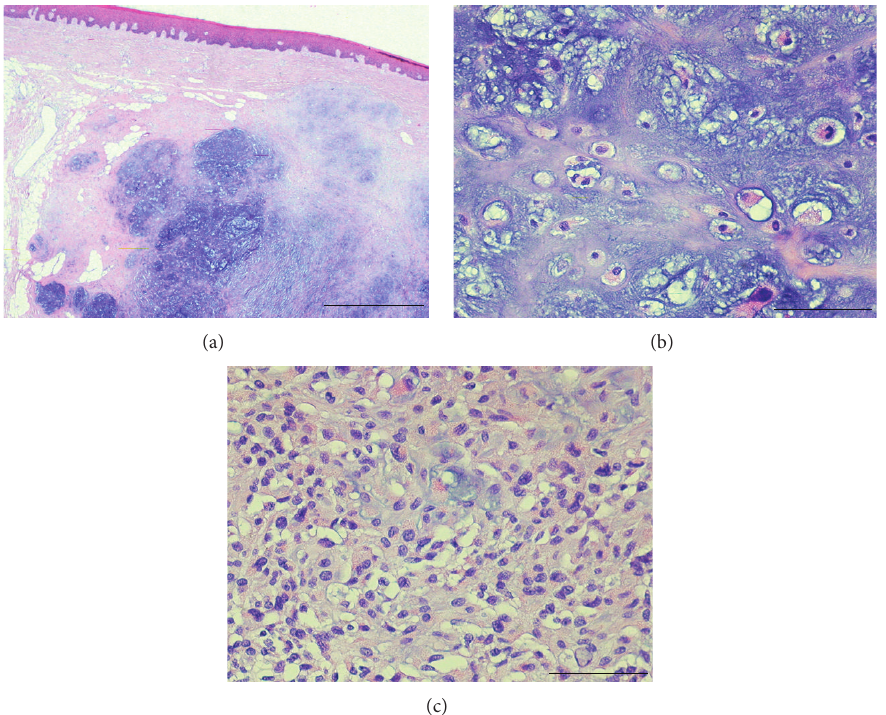
Figure 4: (a) Low-magnification view of the soft tissue chondroma located in the subepitelial hard palate. It shows a multilobular pattern with large blue areas, constituted of cartilaginous tissue, surrounded by a densely sclerotic fibrous tissue. No signs of ulceration are present. Haematoxilin-eosin, original magnification × 2, bar is 1mm. (b) The cartilaginous cells are immersed in an extremely abundant matrix and sometimes are binucleated (arrow). Haematoxilin-eosin, original magnification × 20, bar is 100 𝜇 m. (c) Focally, this lesion is constituted of smaller elements characterised by either oval or reniform nucleus and a slightly eosinophilic cytoplasm. Haematoxilin-eosin, original magnification × 20, bar is 100 𝜇